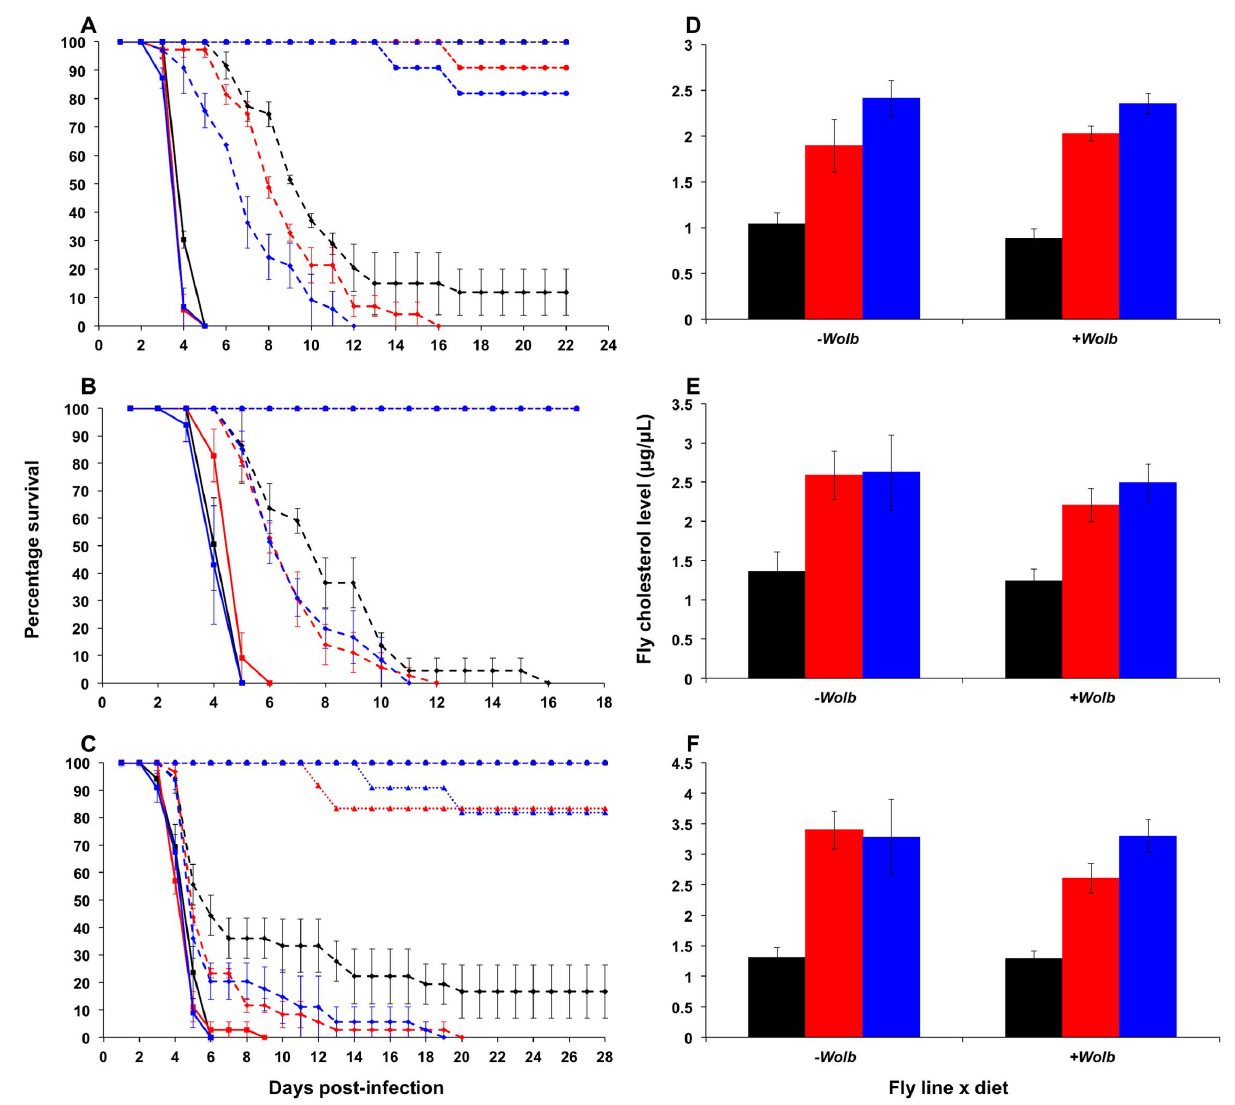
Figure 1. Survival curves and total cholesterol levels for Wolbachia -infected Drosophilamelanogaster fed cholesterol-enriched food. Survival curves for w MelPop- ( A ), w MelCS- ( B ), and w Mel-infected flies ( C ) reared on cholesterol-enriched diets then challenged with DCV by injection into the haemocoel. Each curve represents one of three experiments for that strain. There was a clear effect of diet on survival, where Wolbachia - infected flies (dashed lines with rhomboid markers) reared on the Intermediate (red lines) and High (blue lines) cholesterol-enriched diets had a shorter average survival time than those reared on Standard food (black lines). Each line depicts the mean survival over time ( 6 s.e.m.) for the three vials from each fly line x diet combination. Data were compared statistically using Cox Regression. A delay in virus-induced mortality was observed in Wolbachia -infected flies compared with uninfected (solid lines with square markers). This pathogen blocking effect occurred for all strains with the weakest blocking occurring for the w Mel infection. PBS-injected flies (dotted lines) experienced a high rate of survival with (circles) and without (triangles) Wolbachia , indicating that the death observed in DCV-infected flies was not due to trauma or buffer contamination. Mean levels ( 6 s.e.m.) of total cholesterol and cholesteryl esters for w MelPop- ( D ), w MelCS- ( E ), and w Mel-infected flies ( F ) reared on Standard (black bars), Intermediate (red) and High (blue) cholesterol diets. Cholesterol quantification was performed on flies from the same bottles used in the survival assays. Data were compared statistically using univariate ANOVA followed by student’s t -tests. Flies reared on high cholesterol diets typically had higher cholesterol levels, and this was generally associated with lower mean survival after challenge with DCV.